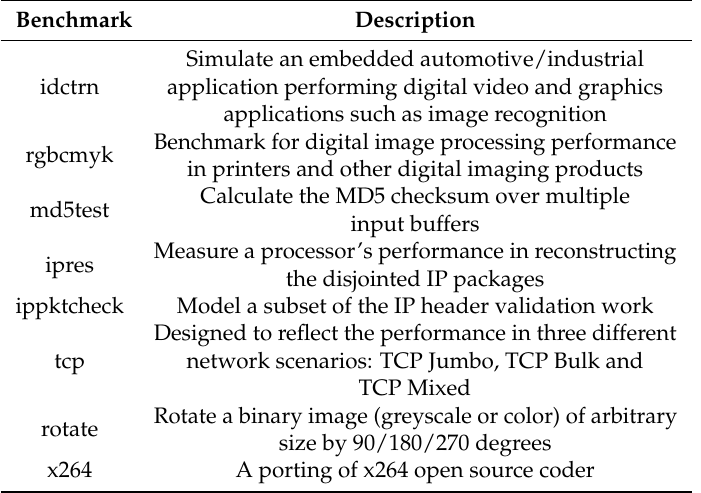
Table 4. EEMBC Benchmark